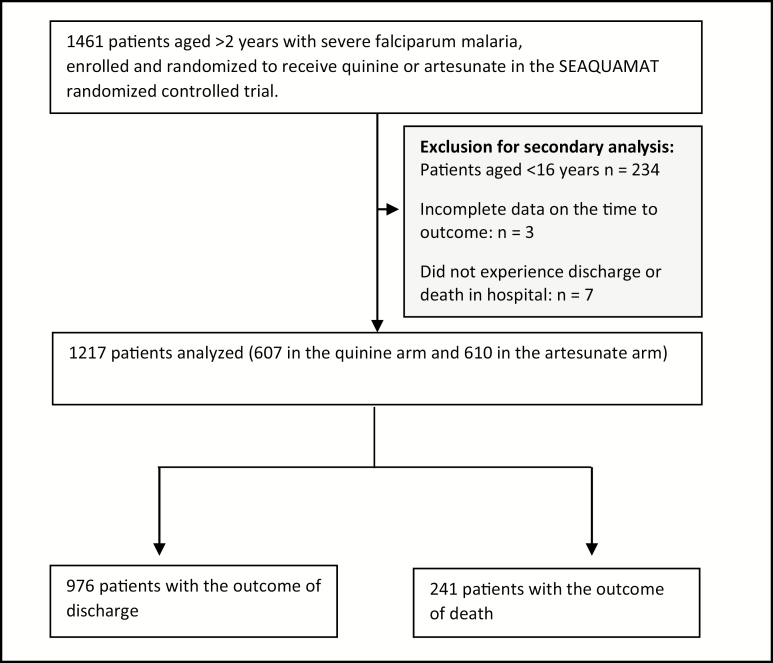
Eligibility flow chart for the secondary analysis of the South-East Asian Quinine Artesunate Malaria Trial dataset. Abbreviation: SEAQUAMAT, South-East Asian Quinine Artesunate Malaria Trial.